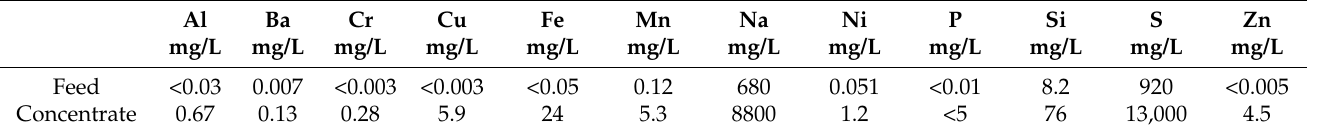
Table 6. Metal concentration of C 2 H 2 O 4 -precipitated feed and concentrate from verification filtration using spiral wound NF90-2540